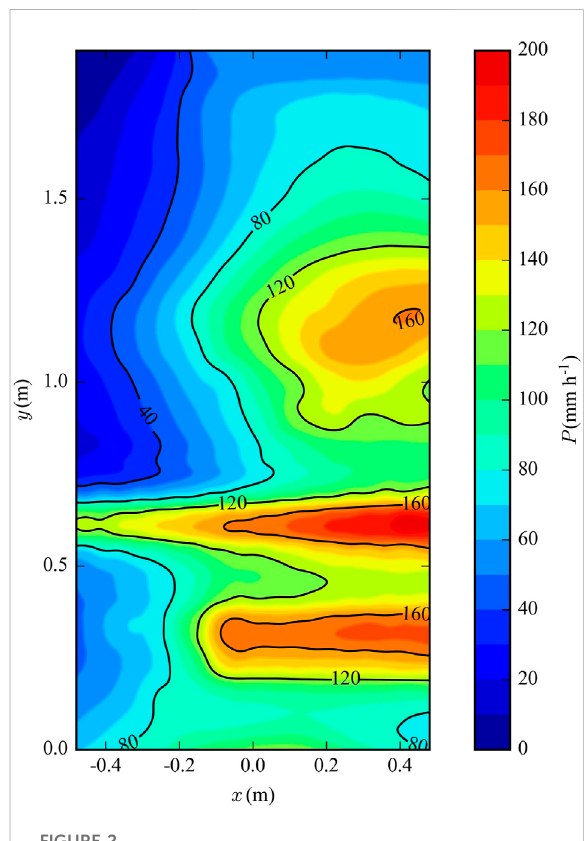
FIGURE 2 Rainfalldistributiononthe fl ume.Theaverageprecipitationand the uniformity coef fi cient were 85 mm h − 1 and 26%, respectively.